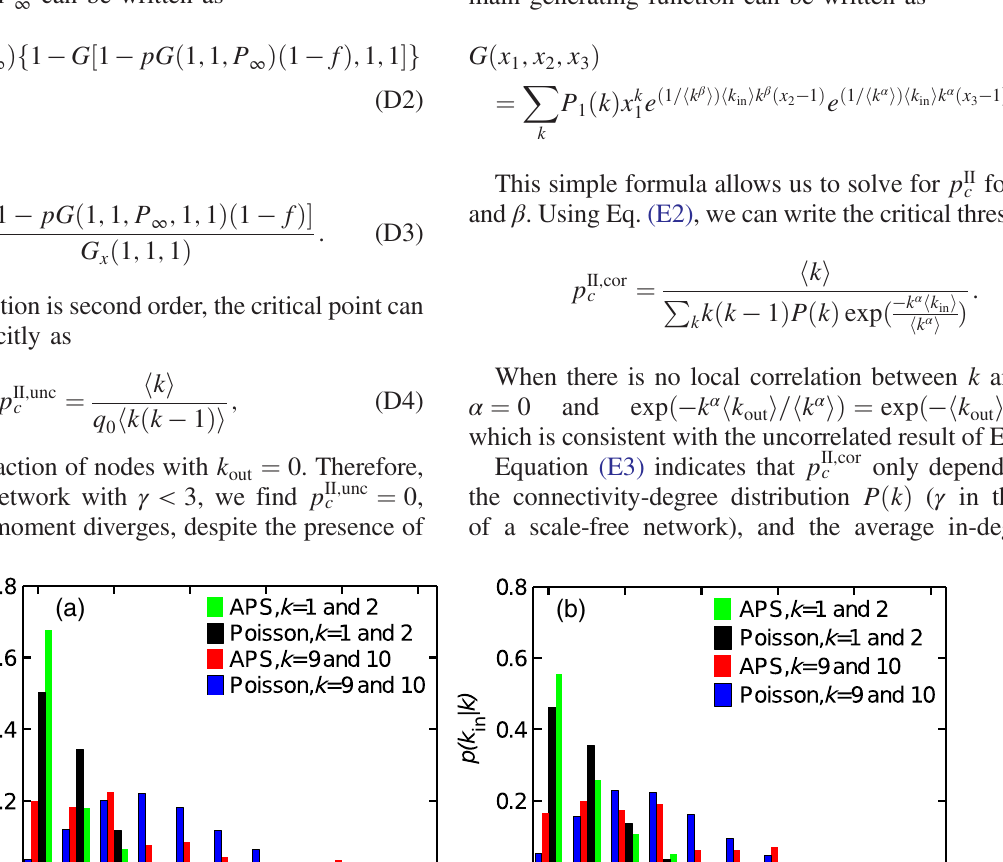
FIG. 8. Distribution of (a) P ð k given k and find that they can be approximated by Poisson